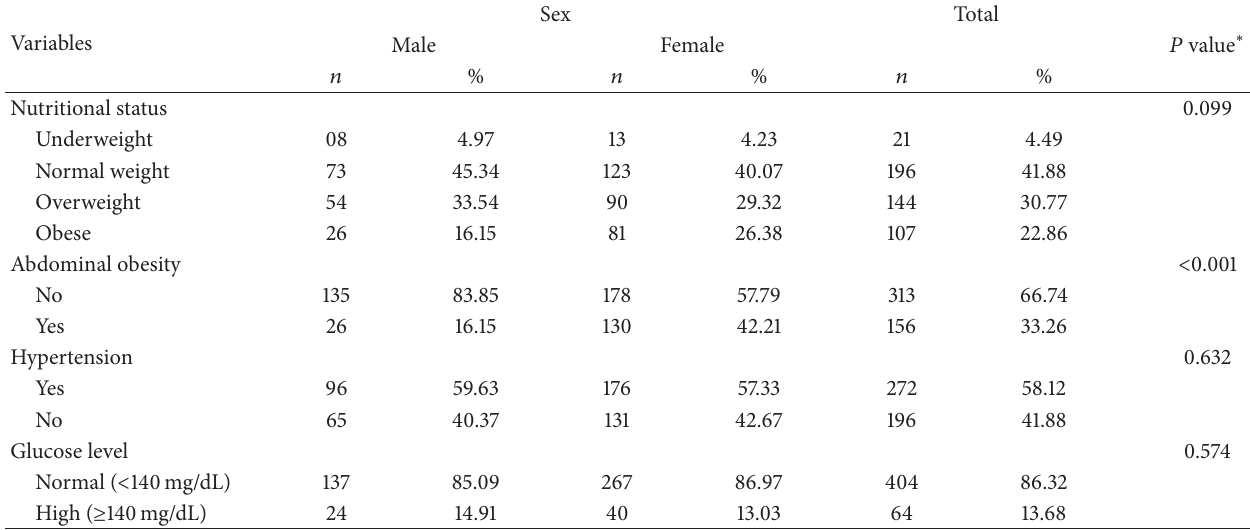
Table 2: Nutritional status, glucose levels, and blood pressure status by sex. Montes Claros, Brazil,